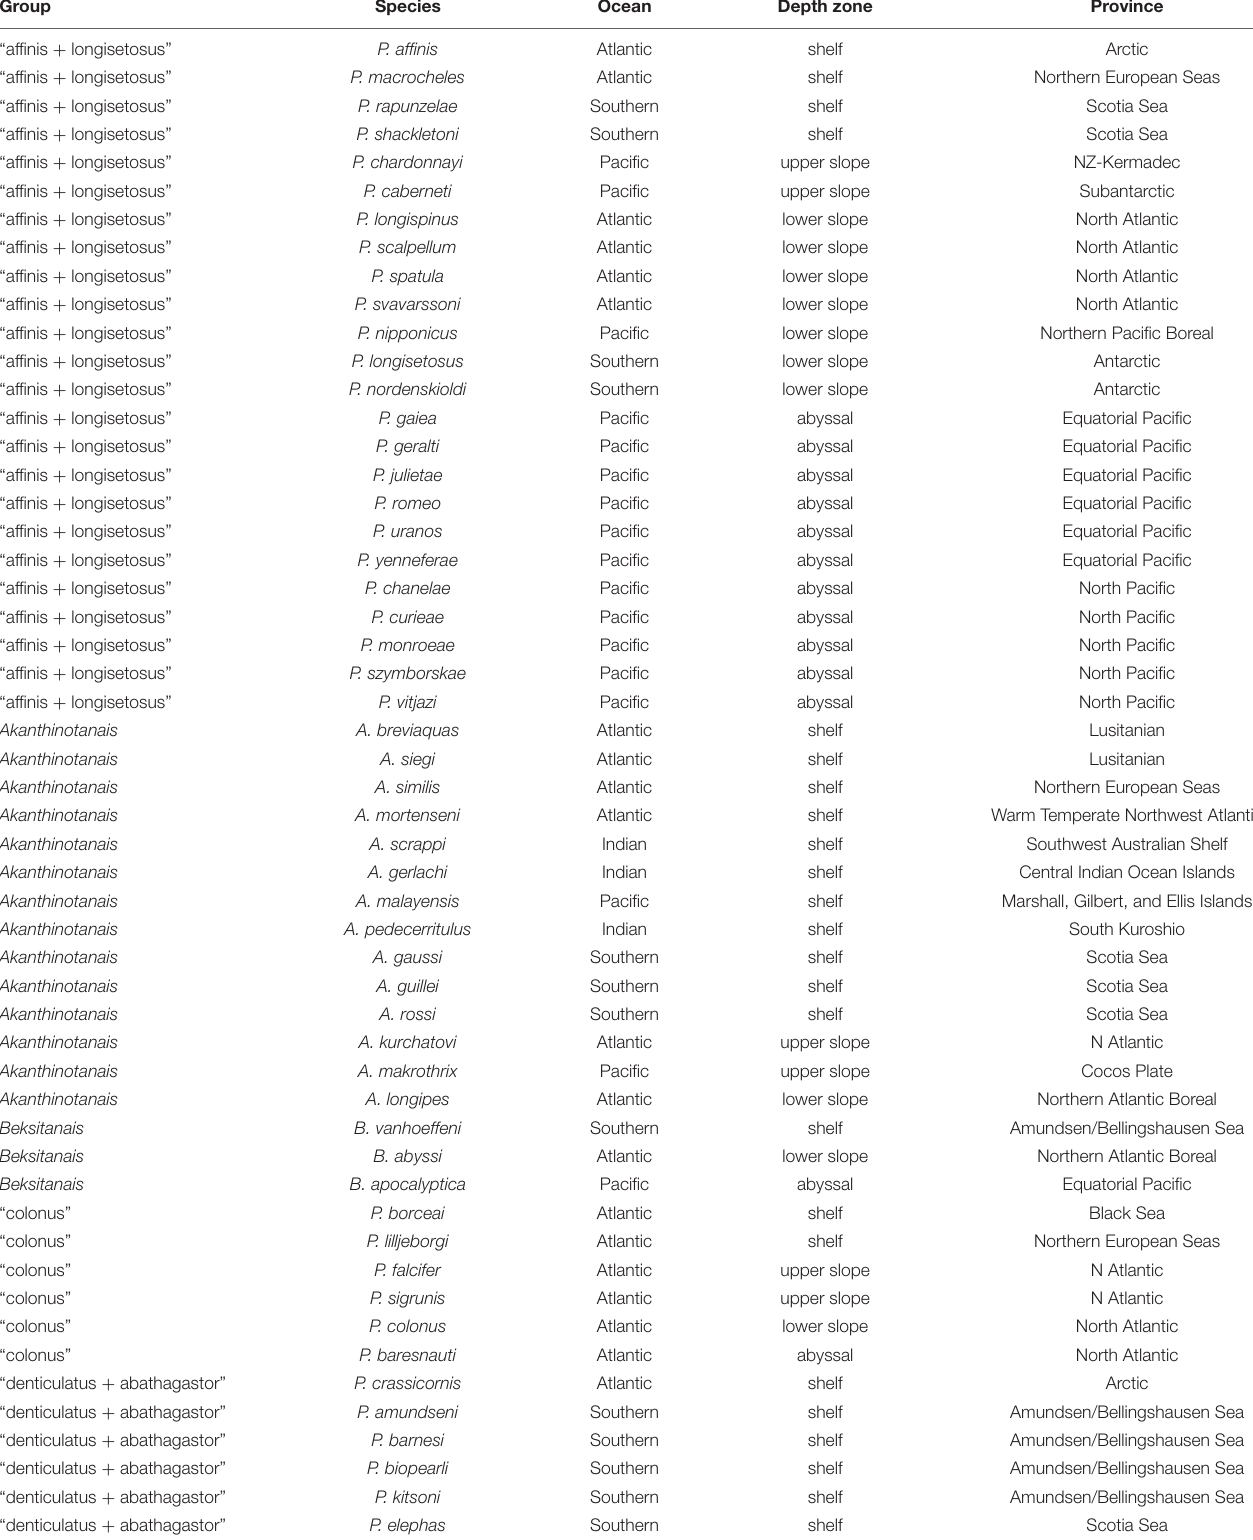
TABLE 2 | Classification of Pseudotanaidae to genera and morpho-groups according to Bird and Holdich (1989b) and McLelland (2007).